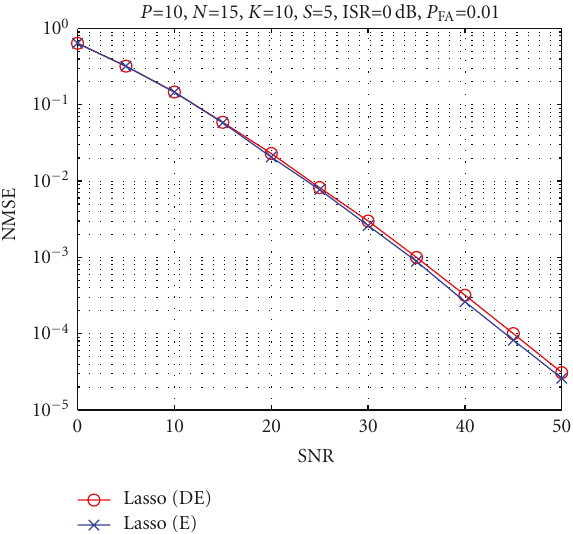
Figure 7: Receiver operating characteristics in a power-controlled scenario with training sequence length P = 10 (asynchronous system with multipath fading channel and unknown K ).